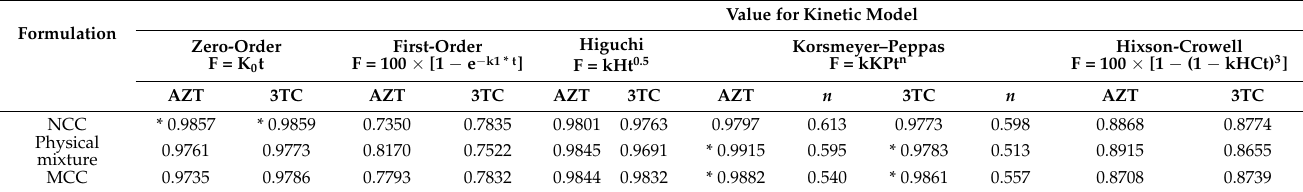
Table 7. Results of fitting in vitro release data to mathematical